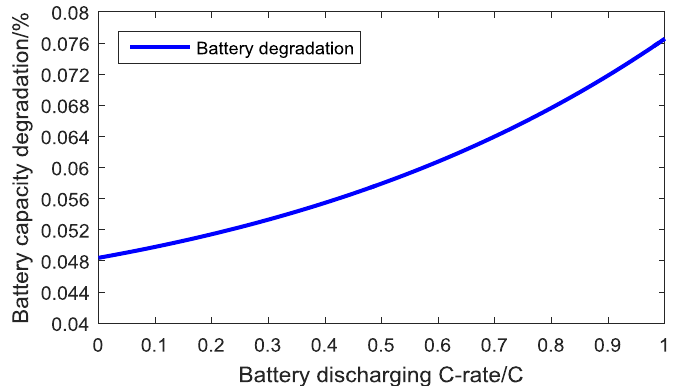
Figure 16. Battery degradation at different C-rates.